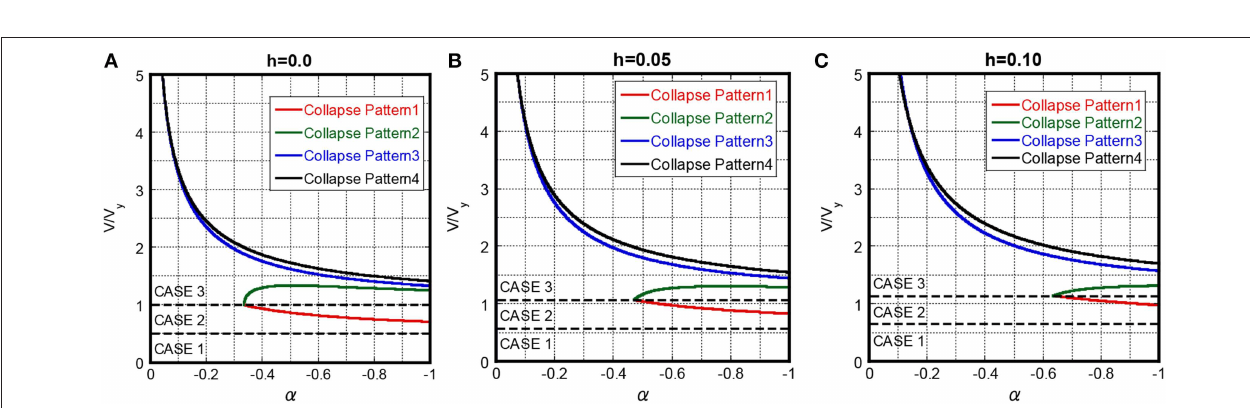
FIGURE 10 | Collapse–limit input velocity level of critical double impulse with respect to post-yield stiffness ratio for specific damping ratio, (A) h (C) h =